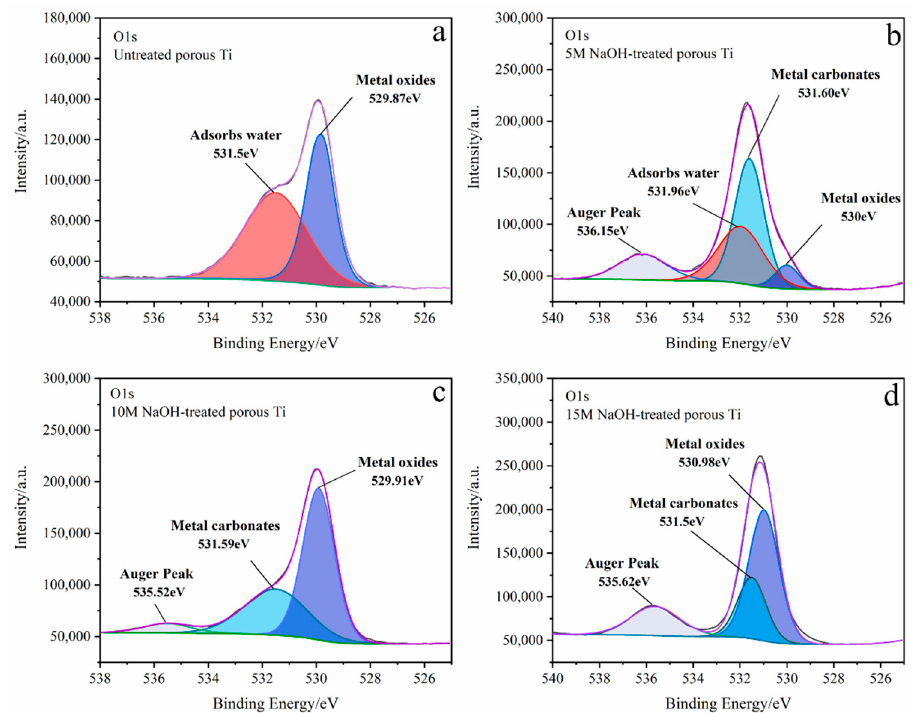
Figure 6. The high resolution fine peak fitting diagram of the binding energy of O element on porous Ti after NaOH treatment with different concentrations, ( a ) O1s peak fitting diagram of untreated porous Ti. ( b ) O1s peak fitting diagram of 5 M NaOH-treated porous Ti. ( c ) O1s peak fitting diagram of 10 M NaOH-treated porous Ti. ( d ) O1s peak fitting diagram of 15 M NaOH-treated porous Ti.